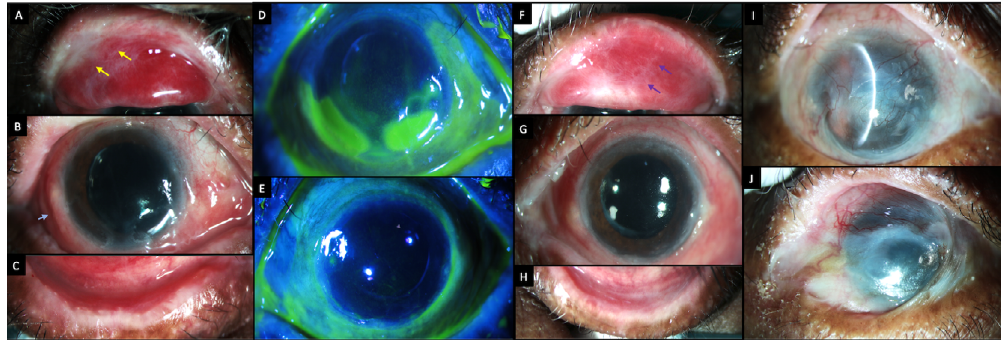
Figure 6. Ocular clinical features at presentation of case 3. (A-C) Slit lamp images of the right eye showing conjunctival congestion, with tarsal scarring superiorly (yellow arrows), limbal thickening (blue arrow) and inferior forniceal shortening. (D, E) Fluorescein-stained images of the right and left eyes respectively showing two epithelial defects in the inferior cornea in the right eye. (F-H) Slit lamp images of the left eye showing tarsal scarring (violet arrows)andinferiorfornicealshortening.(I,J)Imagesoftherightandlefteyerespectivelyafteroneyearoffollowup, showing total limbal stem cell deficiency with a pannus over the cornea. Left eye shows a dermalised ocular surface.